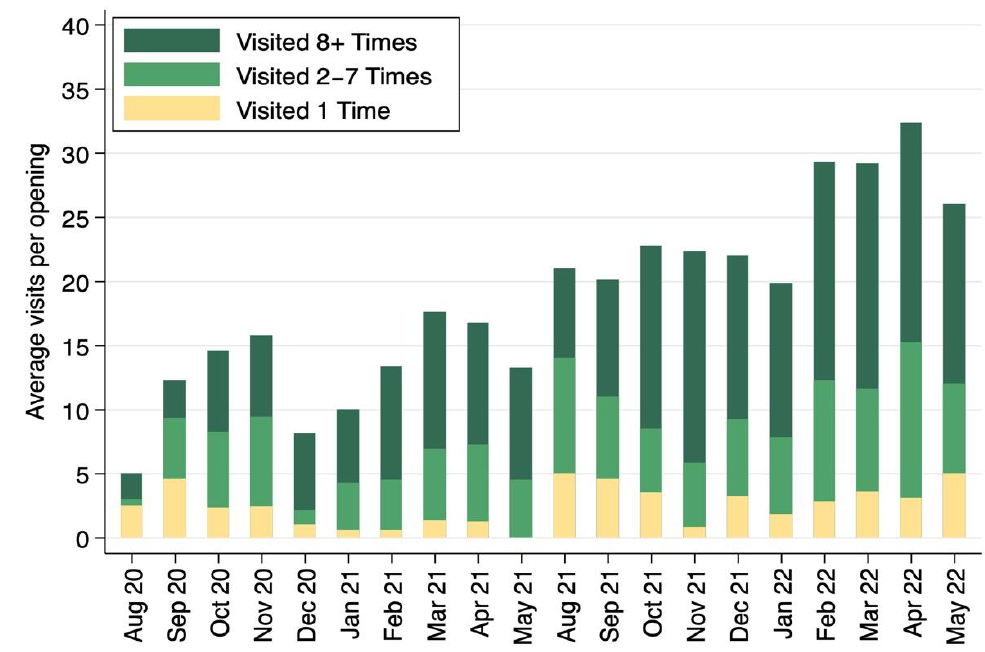
Figure 2. Average campus food pantry visits per opening per month from August 2020 to May 2022 with students grouped by yearly total visits; data from Link2Feed ( n = 579).